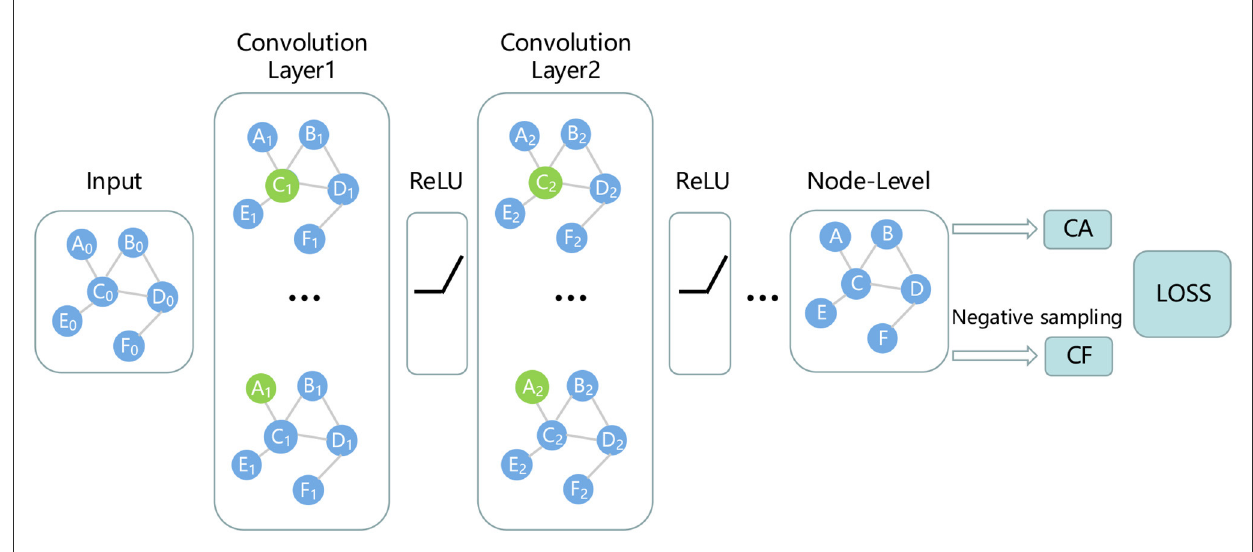
FIGURE2 Prediction of miRNA-disease associations using GCN.